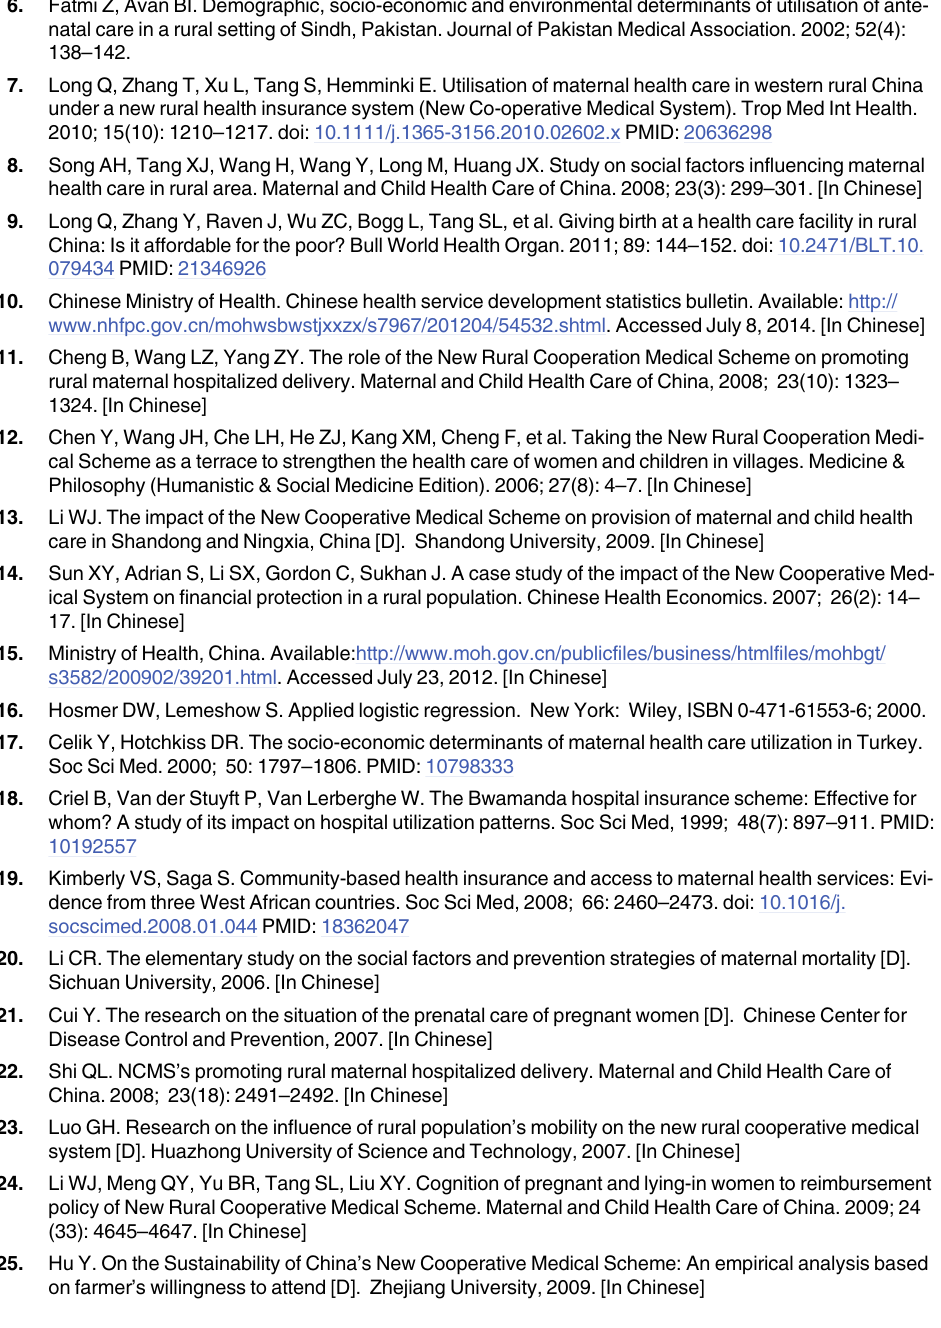
PLOS ONE | DOI:10.1371/journal.pone.0158473 July 7,